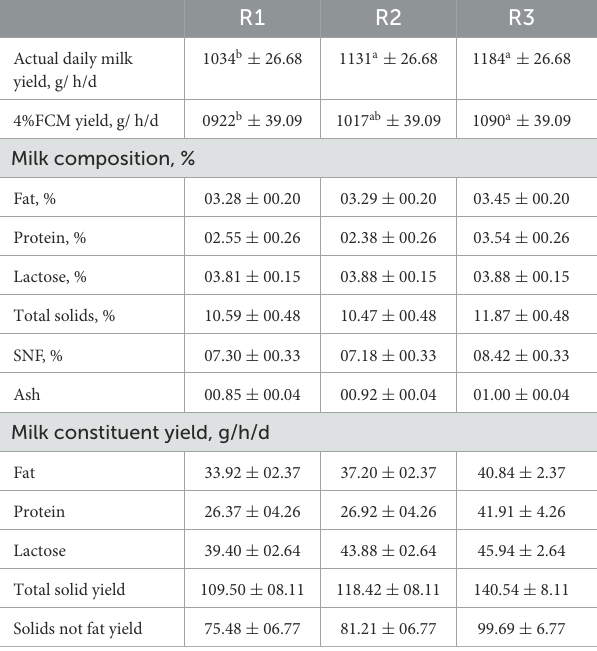
TABLE 6 Effects of the inclusion of azolla (SDAM) unconventional feed on milk yields and milk composition of Zaraibi dairy goats. R1 R2 R3 Actual daily milk yield, g/ h/d